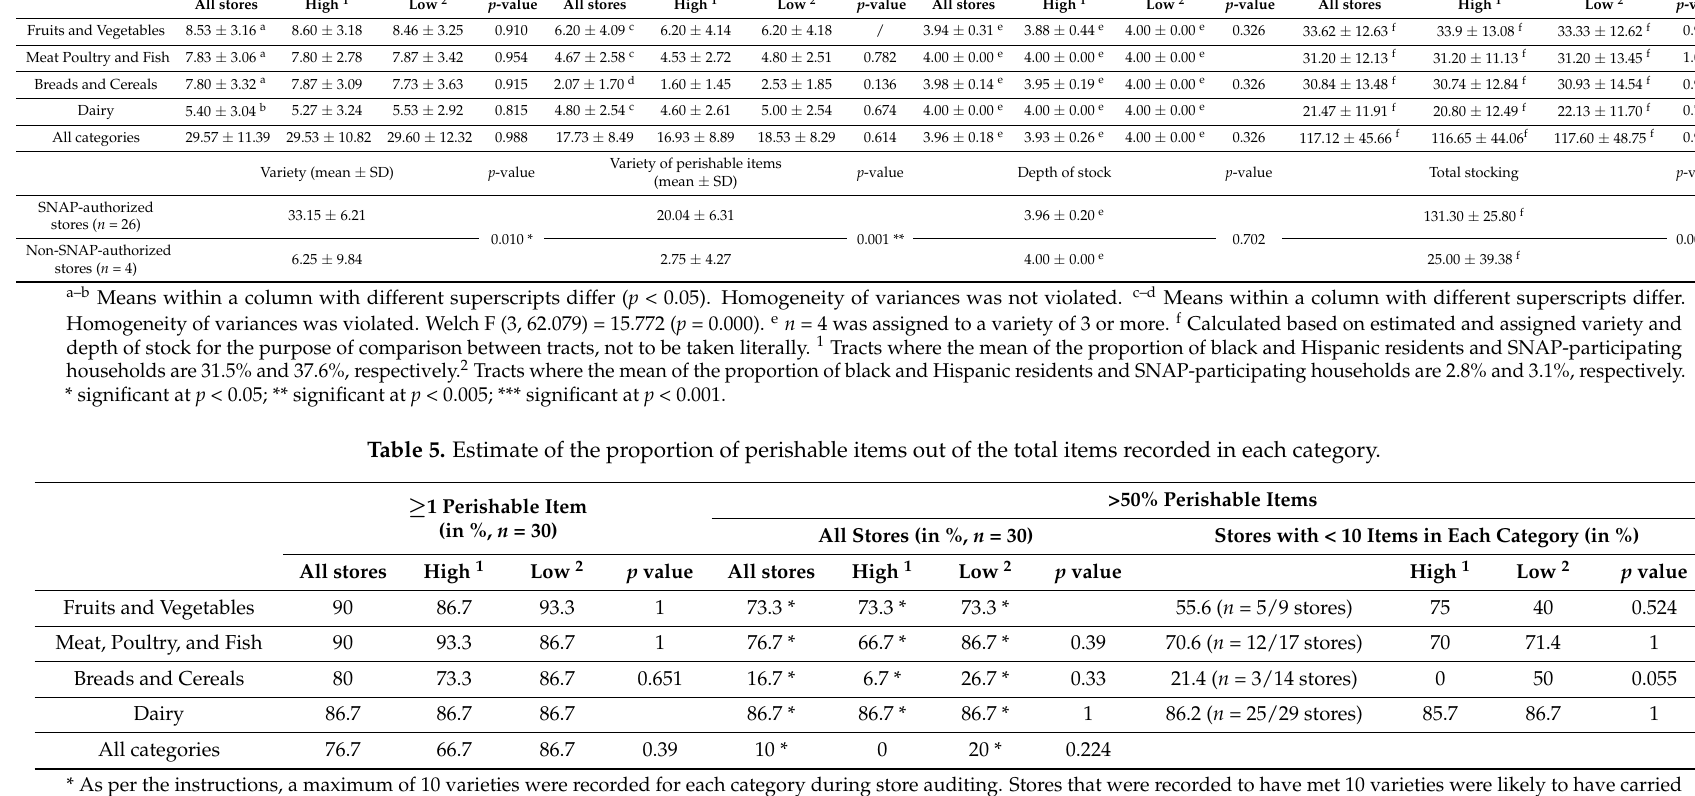
Table 4. Mean of variety, variety of perishable items, depth of stock, and total stocking in each category ( n = 30). Variety(mean ± SD) VarietyofPerishableItems (mean ± SD) DepthofStock TotalStocking Allstores High 1 Low 2 p -value Allstores High 1 Low 2 p -value Allstores High 1 Low 2 p -value Allstores Low 2 p -value